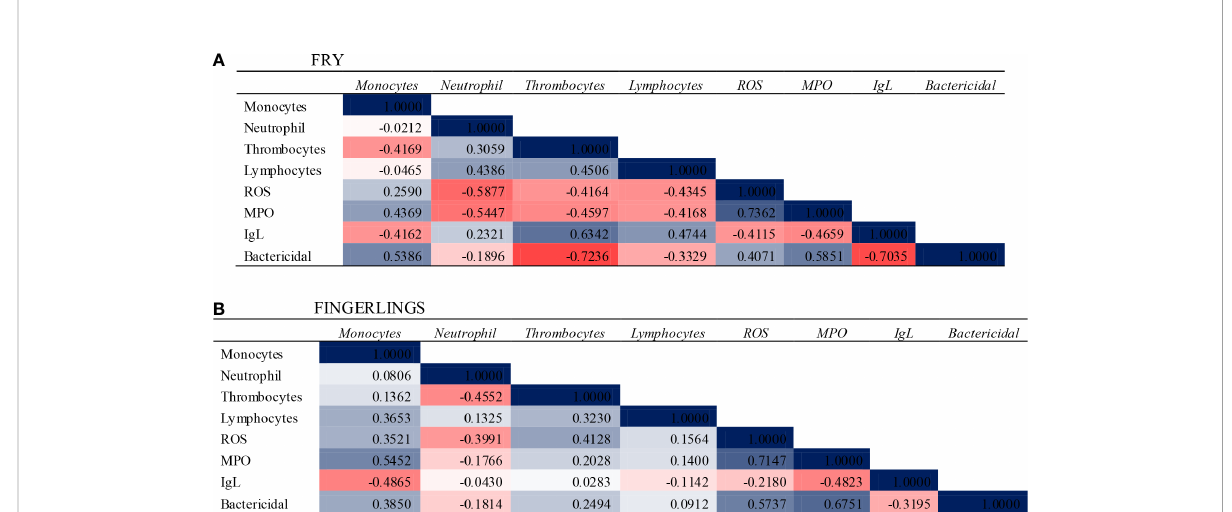
FIGURE 2 Correlation Analysis and heat map showing the relationship between the immune associated parameters when the Asian seabass L. calcarifer exposed to OA for 60 d. (A) Fry (B) Fingerlings. The values and colour depict the relationship between the